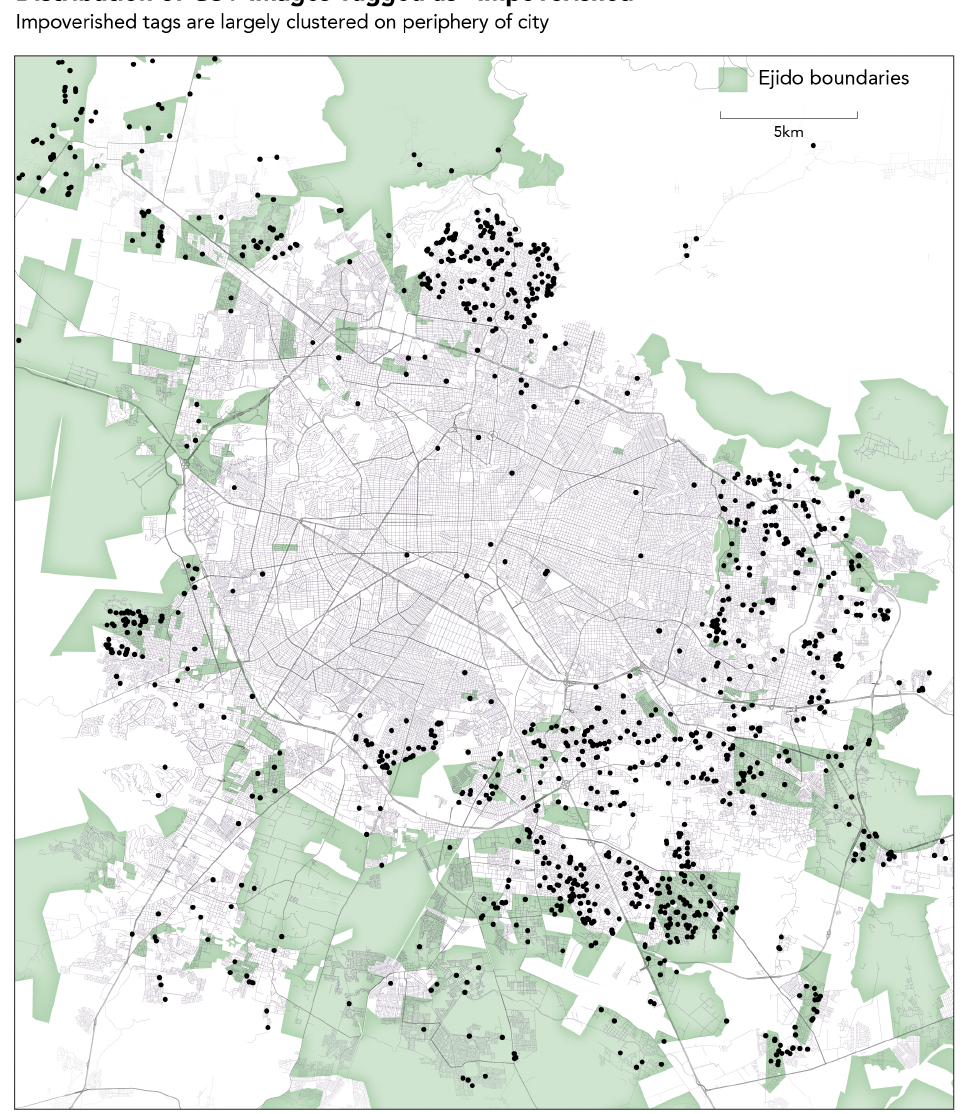
Figure 7. Google Street View (GSV)-impoverished